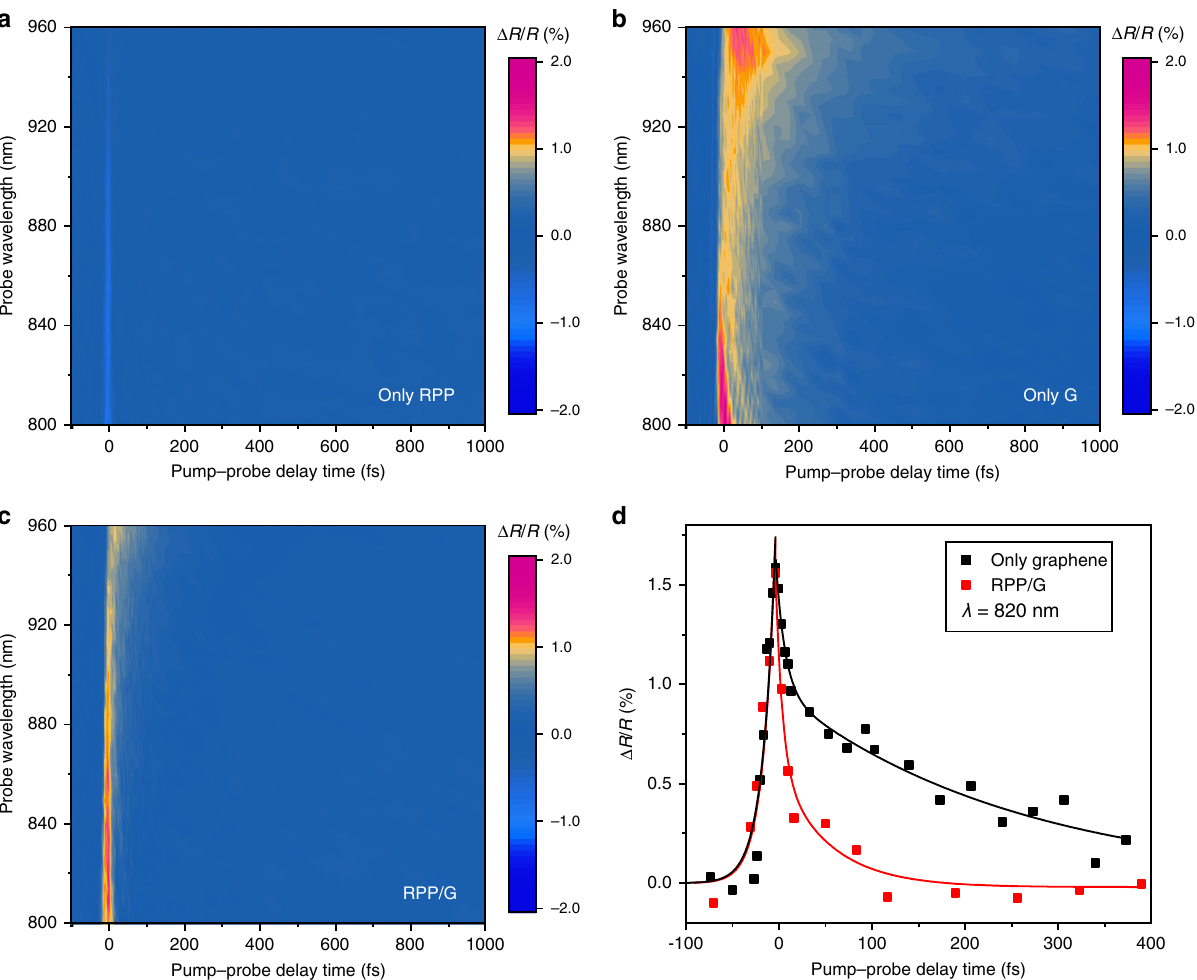
Fig. 4 Femtosecond pump-probe study of dynamic photocarrier injection across RPP/G heterostructure. a – c Differential re fl ectivity spectra of (a) n = 4 RPP fl ake, b G, and c RPP/G heterostructure as a function of pump-probe delay time and probe wavelength, when pumping at 25 pJ/ μ m 2 peak energy density. d Cross-section of the data plotted in ( b and c ) at λ = 820 nm. Solid lines in the graph correspond to fi ts considering exponential growth ( t < 0 fs) and decay ( t > 0 fs)